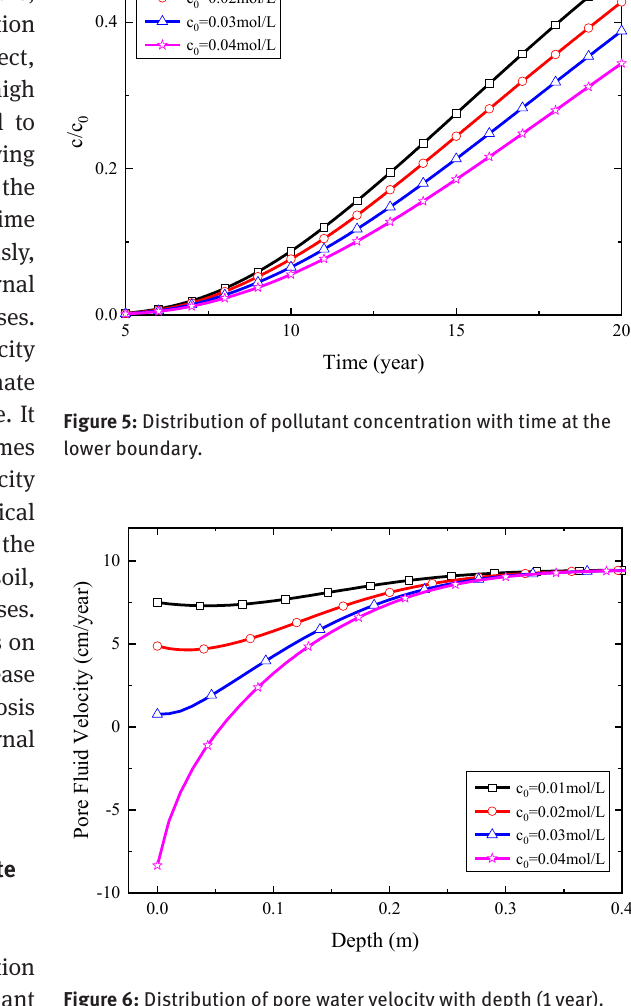
Figure 6: Distribution of pore water velocity with depth (1 year).